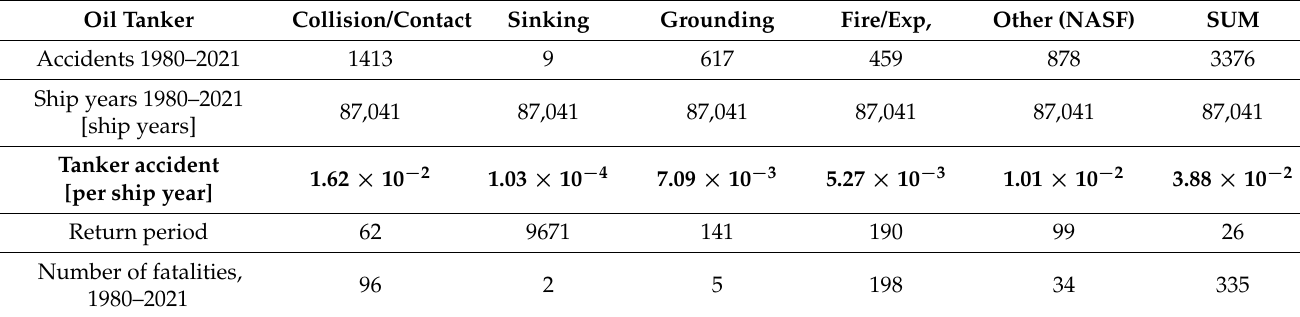
Table 1. Frequency pea accident type for